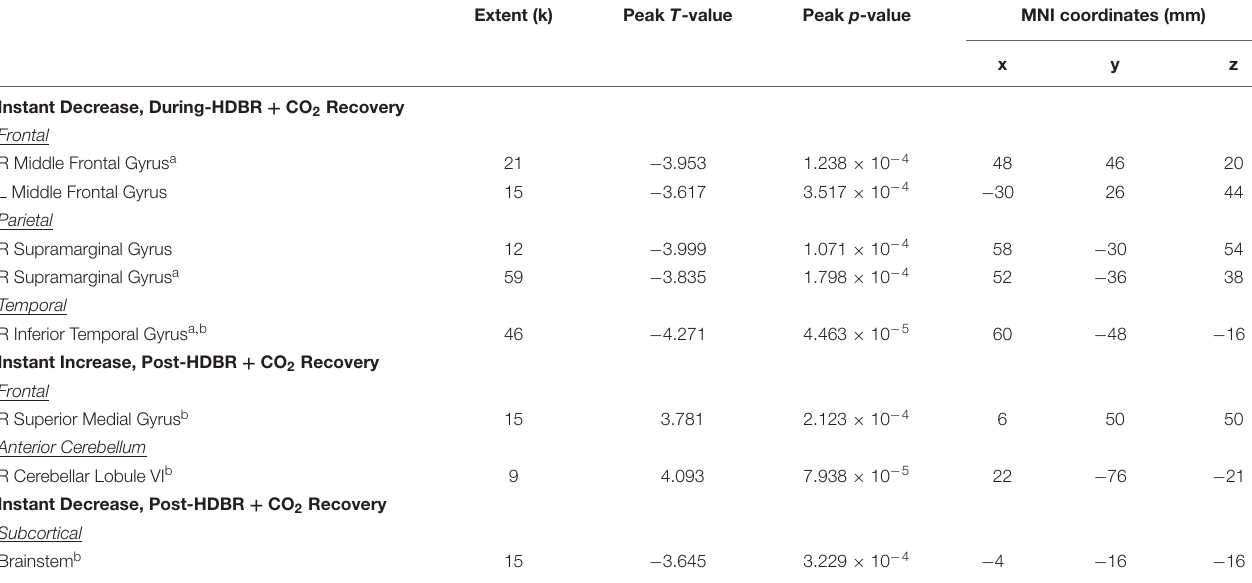
TABLE 2 | Regions showing longitudinal increases and decreases in activation during vestibular stimulation across all six time points. Extent (k) Peak T -value Peak p -value MNI coordinates (mm)